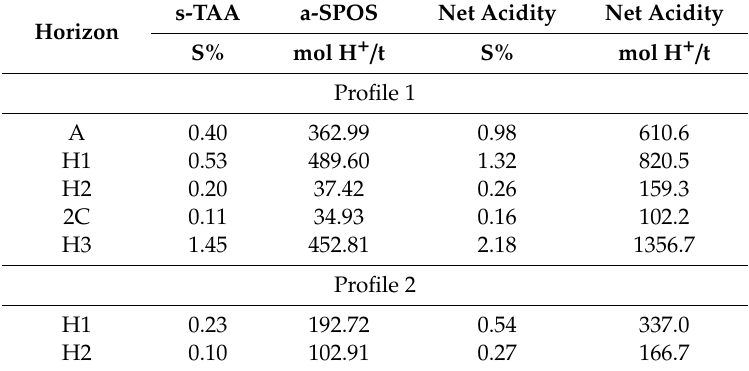
Table 5. Conversions and net acidity results for profiles 1 and 2. s-TAA: Actual acidity with sulfur units; a-SPOS: Potential acidity with acidity